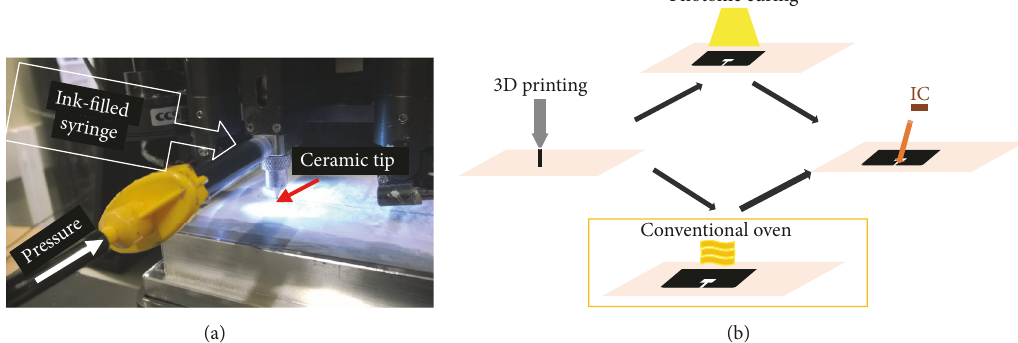
Figure 1: (a) 3D microdispensing system with an ink syringe and a ceramic nozzle tip and (b) schematic process of antenna fabrication.